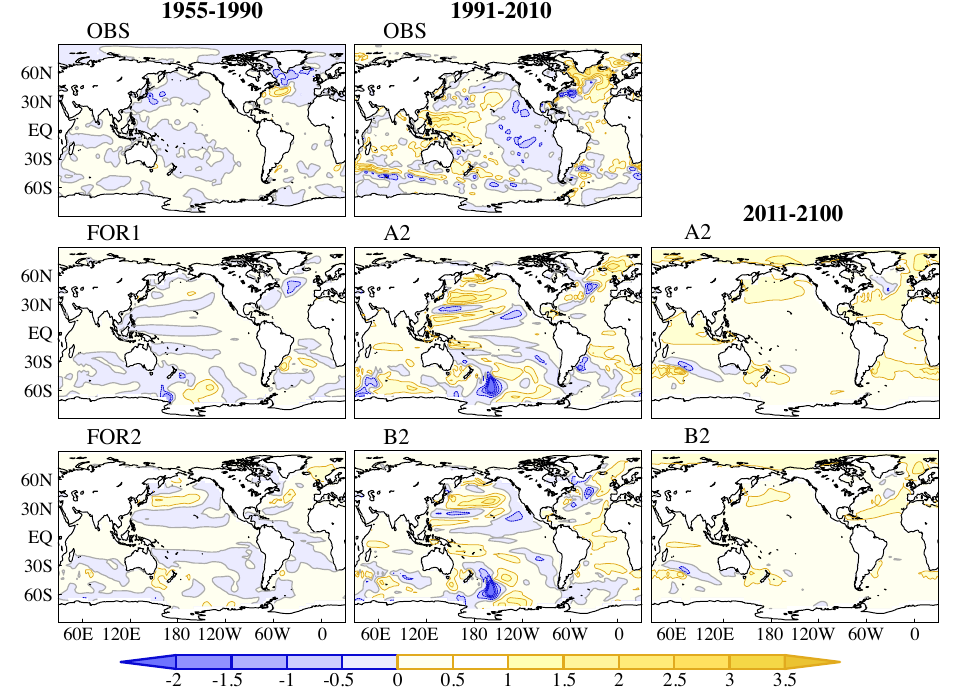
Fig. 3. Linear trends of the observed (top panel) and simulated (lower panels) OHC700 (in 10 8 Jm − 2 yr) in the upper 700 of the ocean for the periods 1955–1990 (left), 1991–2010 (middle) and 2011–2100